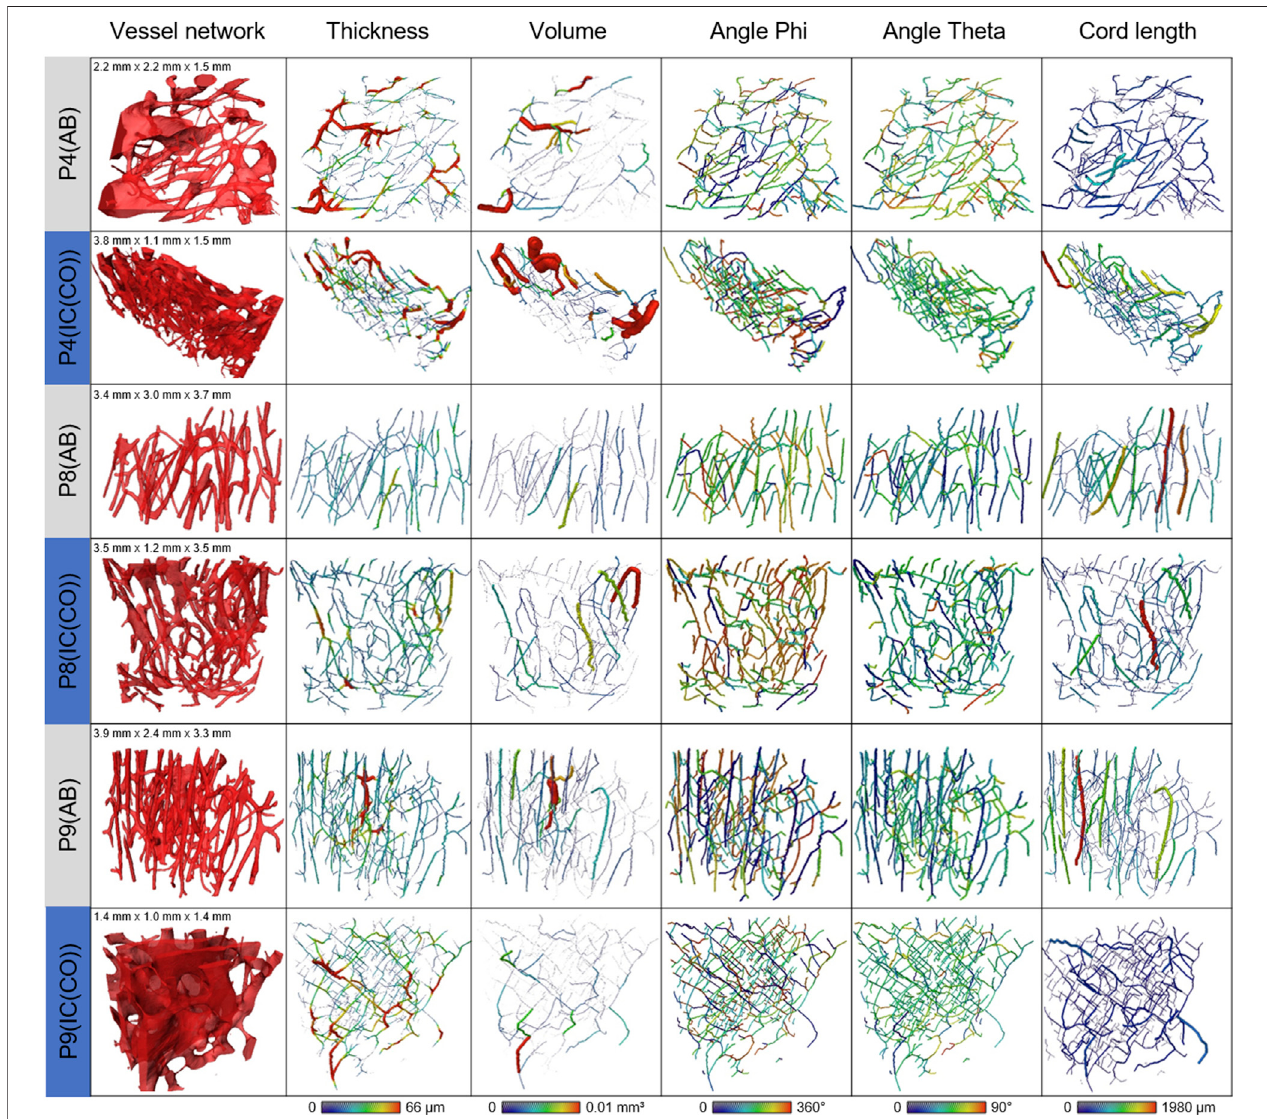
FIGURE 5 | Summary of the skeletonized vessel pores comparing the volumes, thickness, and orientation of the skeleton fragments between AB and IC (CO). Visualizations of (A) vessel network, (B) thickness, (C) volume, (D) angle phi, (E) angle theta, and (F) cord length.